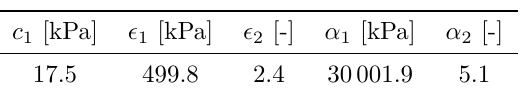
Table 1. Material parameters for arterial tissue, ad- justed by Brands et al. [16] to the model from [9].